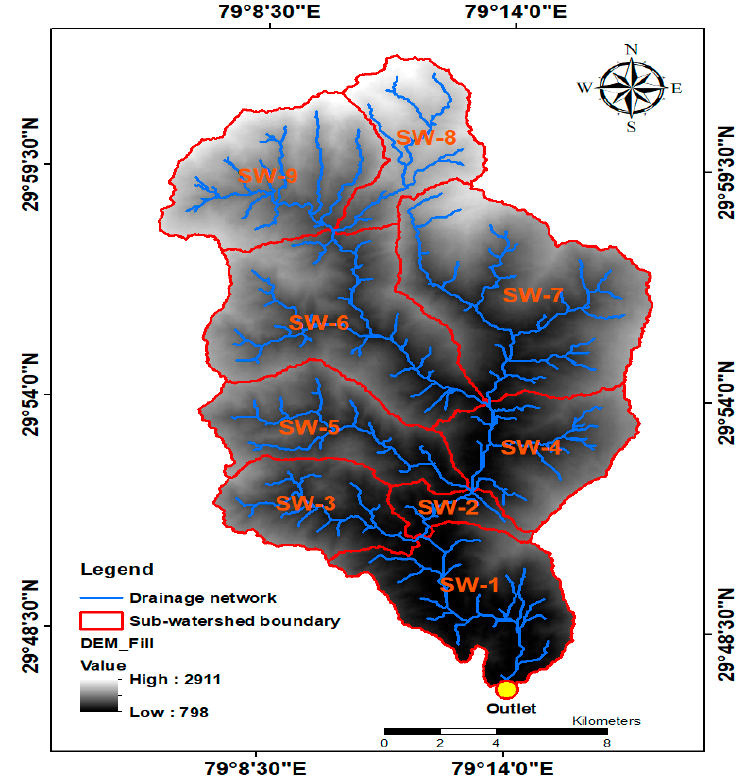
Figure 2. DEM and drainage network pattern of nine sub-watersheds of BW.